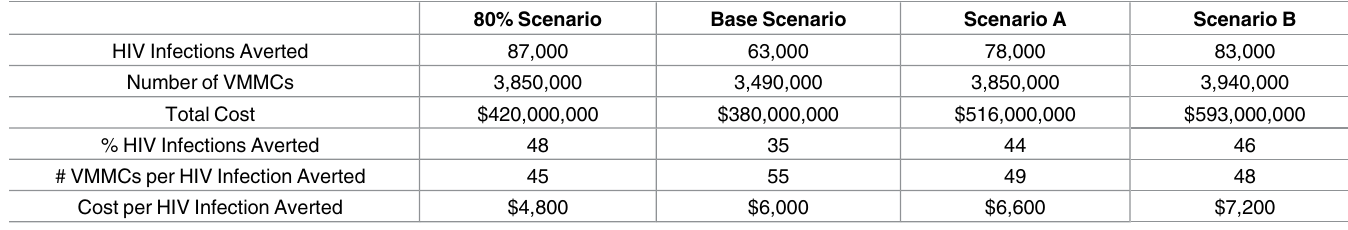
Table 2. Cost and Impact of the Four Scenarios, 2015–2029.